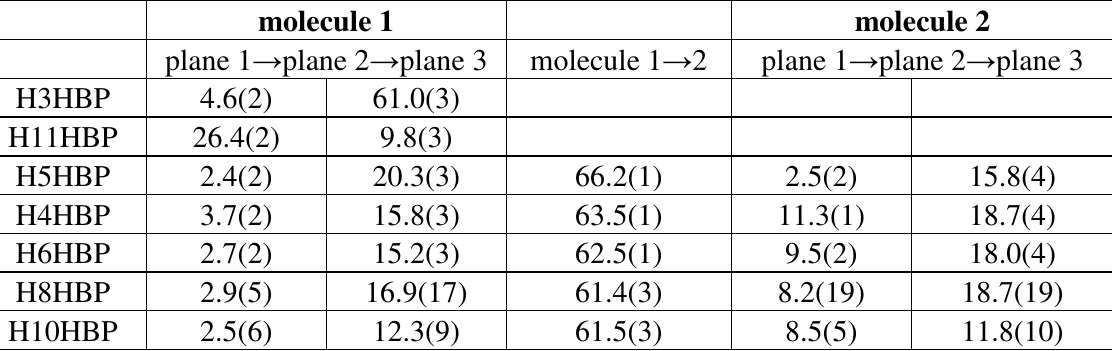
Table 2. Twist between the planes of different parts of single molecules of HnHBP and between plane 1 of the two molecules, which form the asymmetric units in degrees.